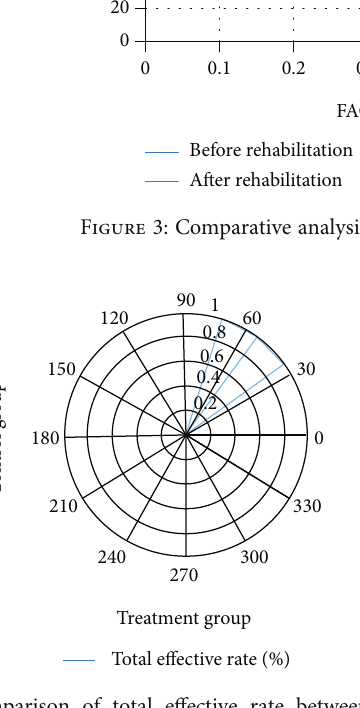
Figure 4: Comparison of total e ff ective rate between the two groups (example).